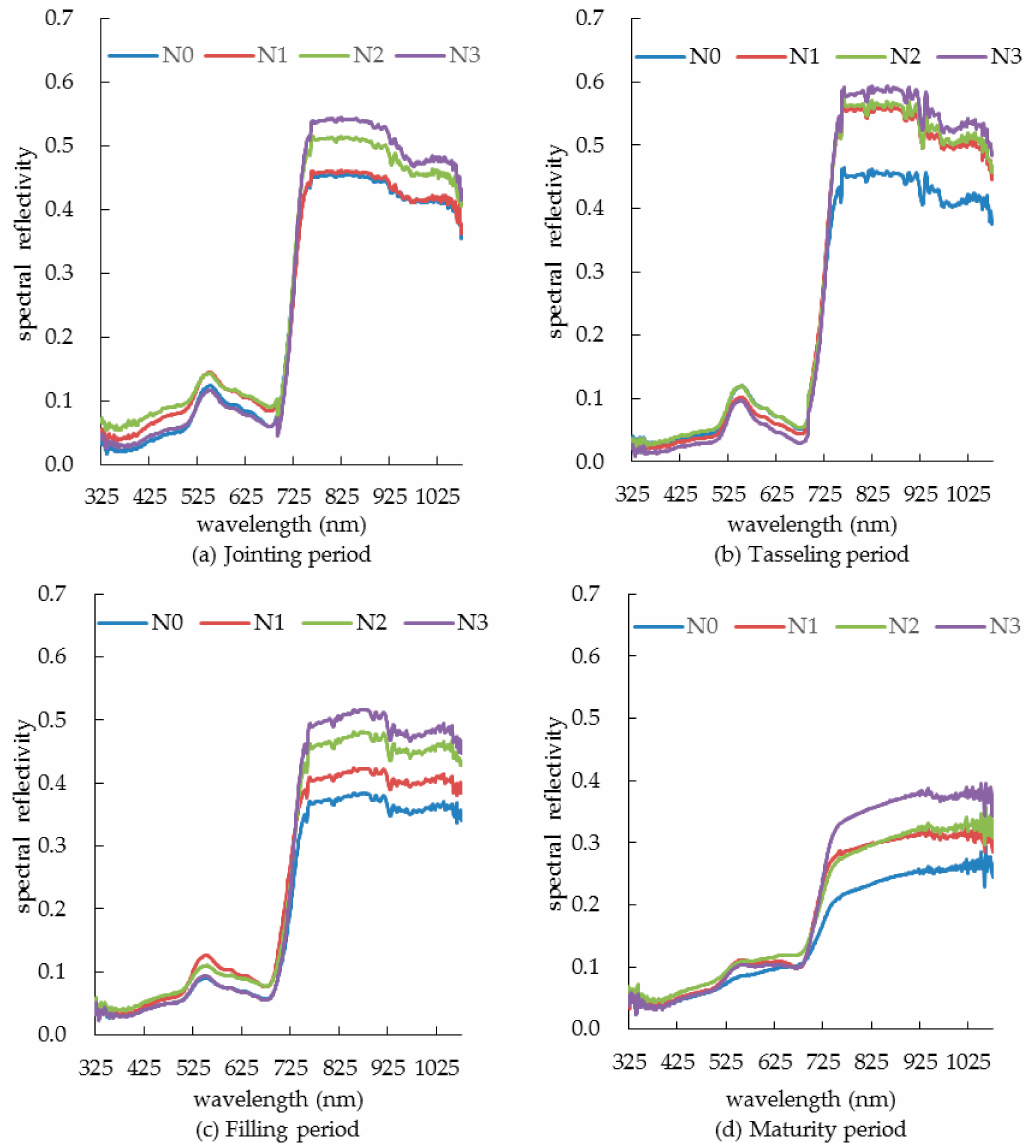
Figure 3. E ff ect of nitrogen application levels on canopy spectral reflectance curve of summer